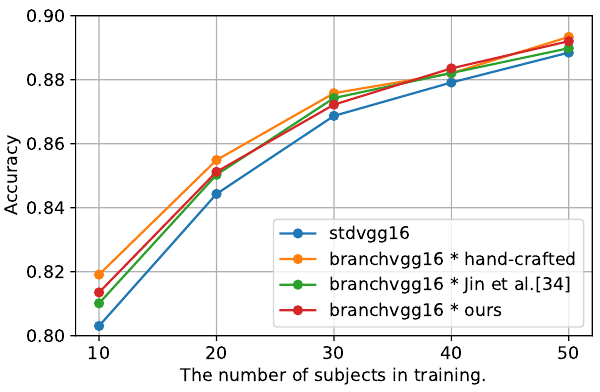
Figure 4. Effect of varying the number of subjects used for training on